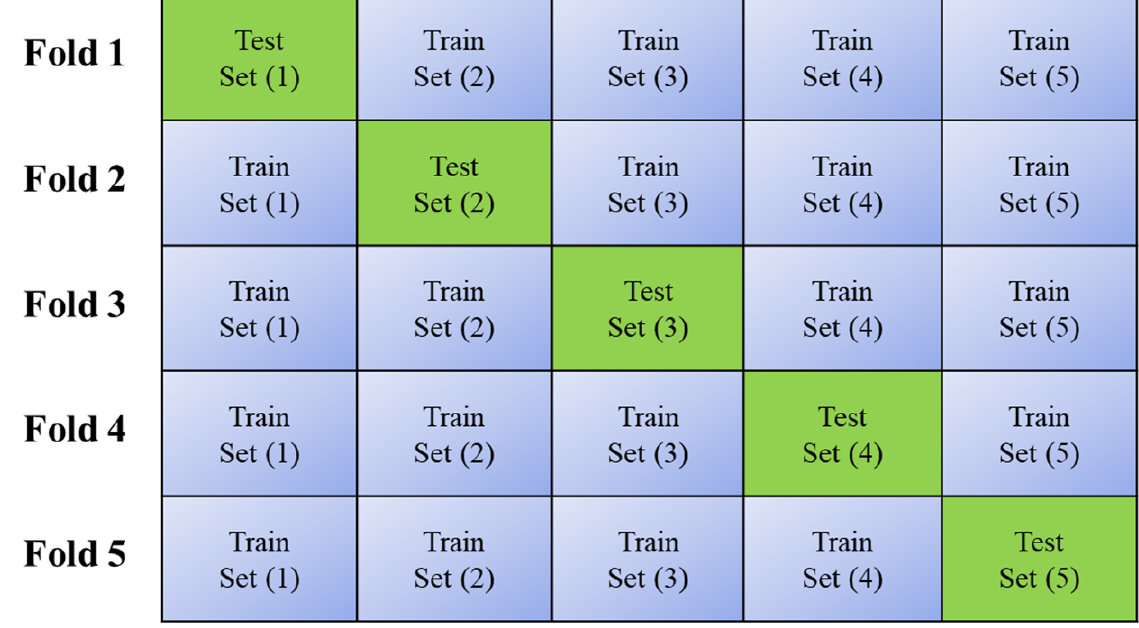
Figure A3. Confusion matrix of four rounds of the FLAIR-MRI dataset using the MajVot algorithm.